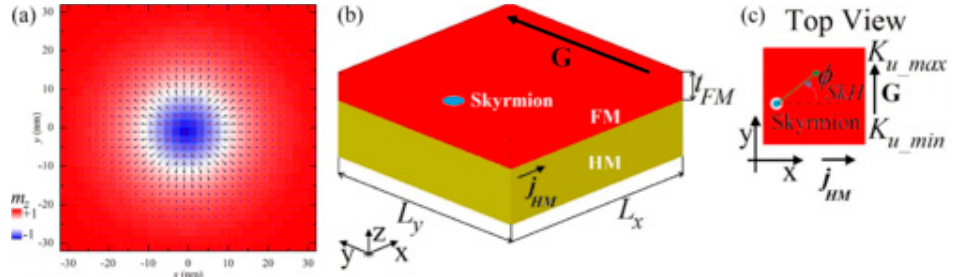
Figure 3. ( a ) Micromagnetic simulation of a symmetric Néel skyrmion with negative polarity; ( b ) ferromagnet/heavy metal bilayer with skyrmion, current in the heavy metal j HM and anisotropy gradient G; ( c ) top view on the ferromagnetic layer with the skyrmion Hall angle and the aforementioned driving parameters. Reprinted with permission from [40]. Copyright (2018) by the American Physical Society.